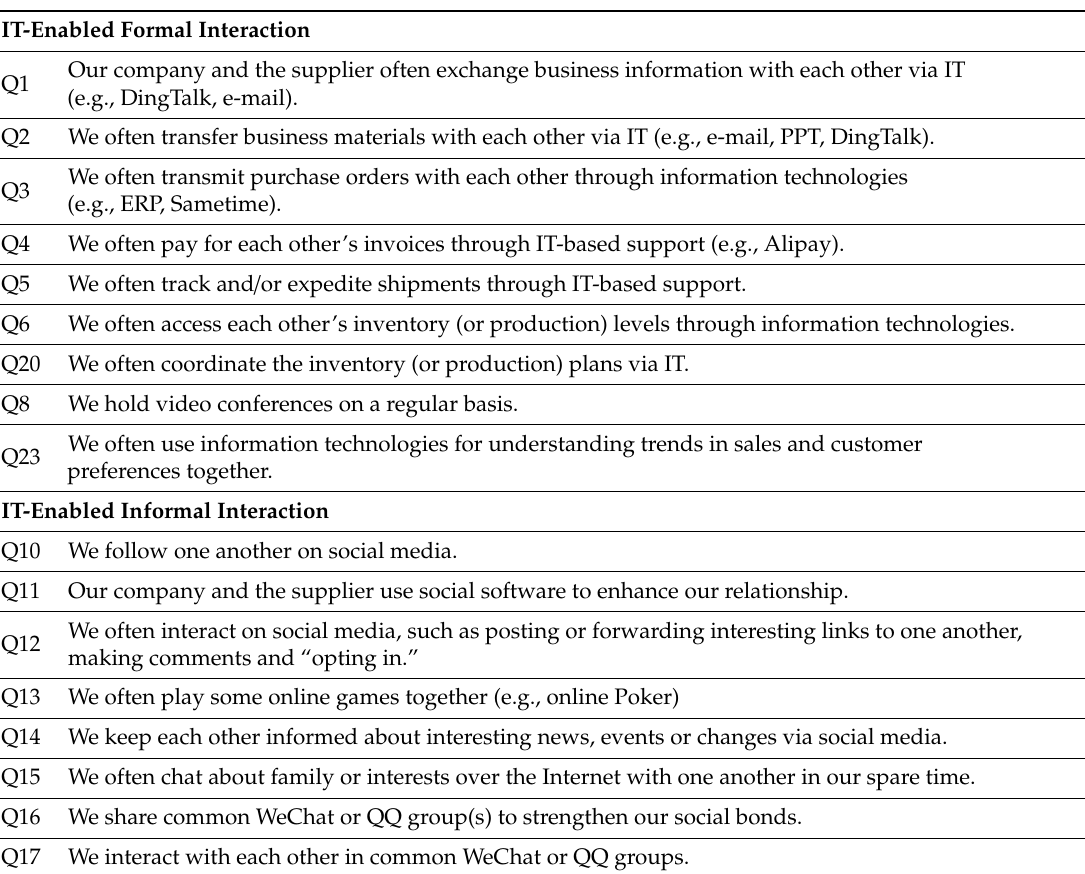
Table 3. The Preliminary IT-Enabled Interaction Item